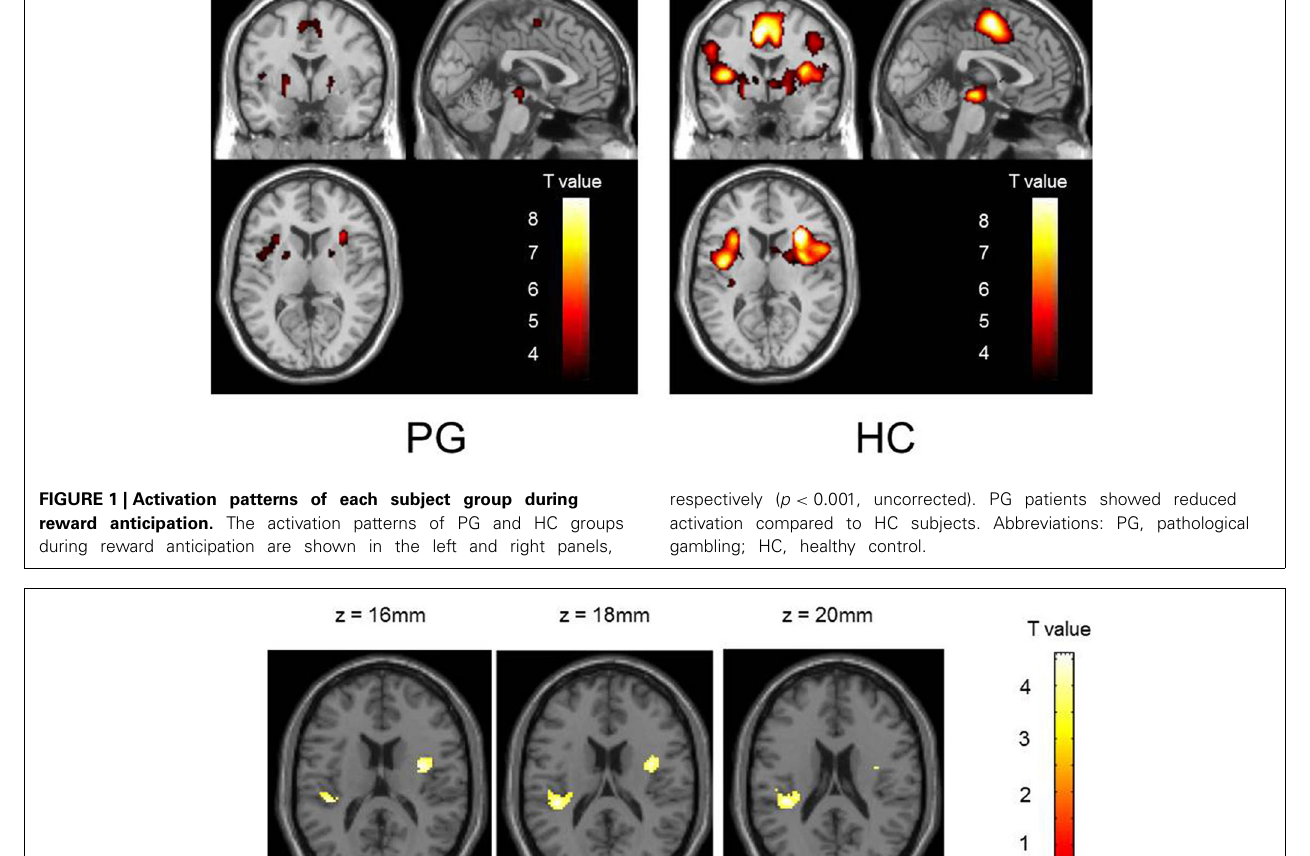
FIGURE 2 | Differences in activation during reward anticipation in the insula between groups. Pathological gambling patients showed blunted activation compared to healthy controls (masked by insular region of interest; p < 0 . 05, small volume corrected).